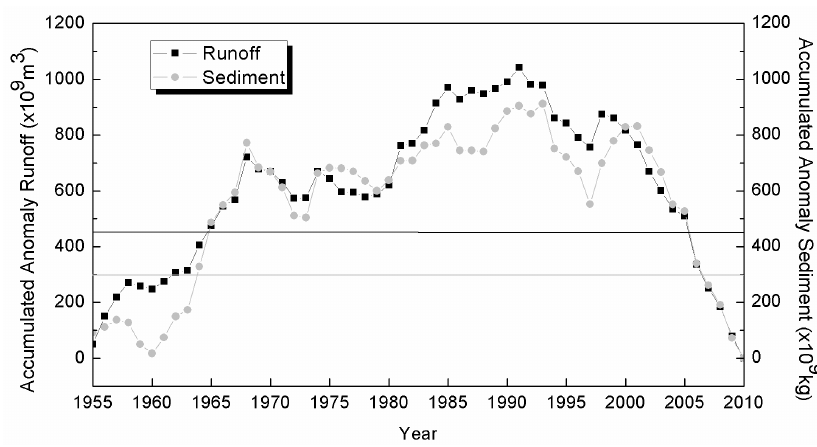
Figure 4. Accumulated Anomaly Curves of Runoff and Sediment during 1955 to 2010.